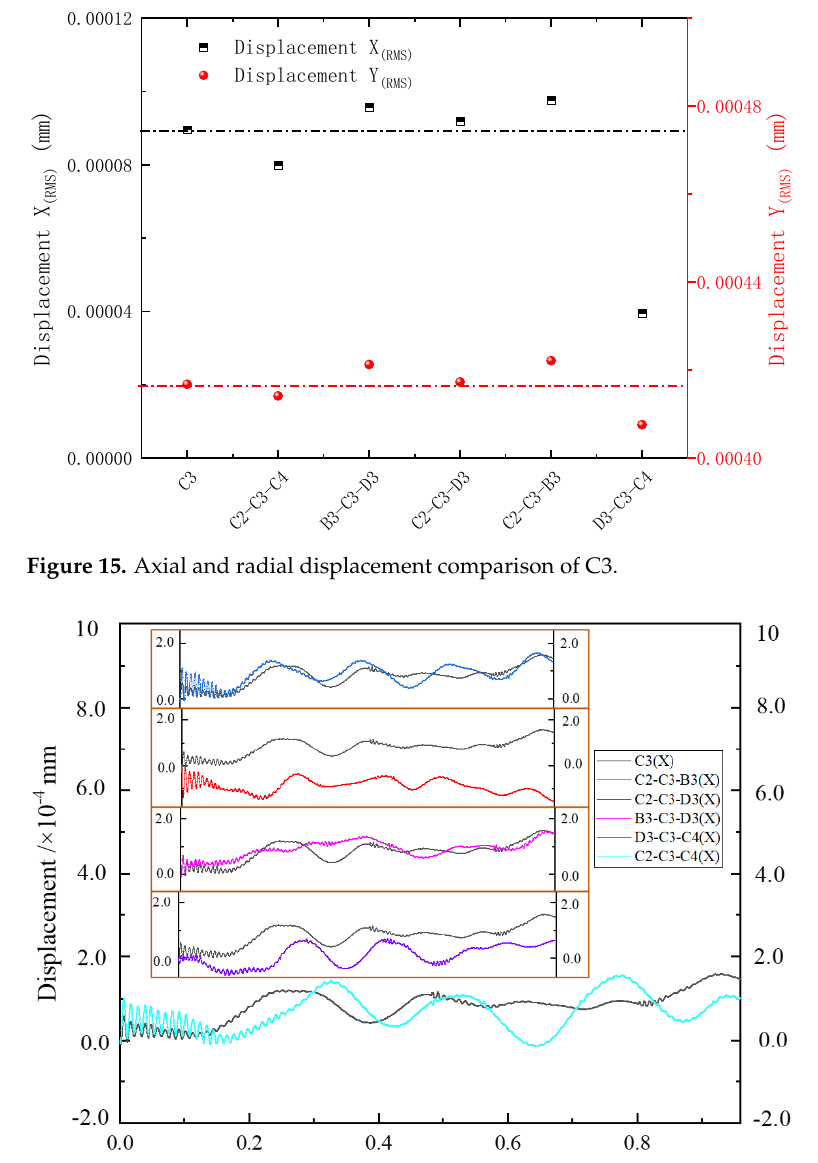
Figure 14. Comparison of the lift and drag coefficient of C3 in the time domain.